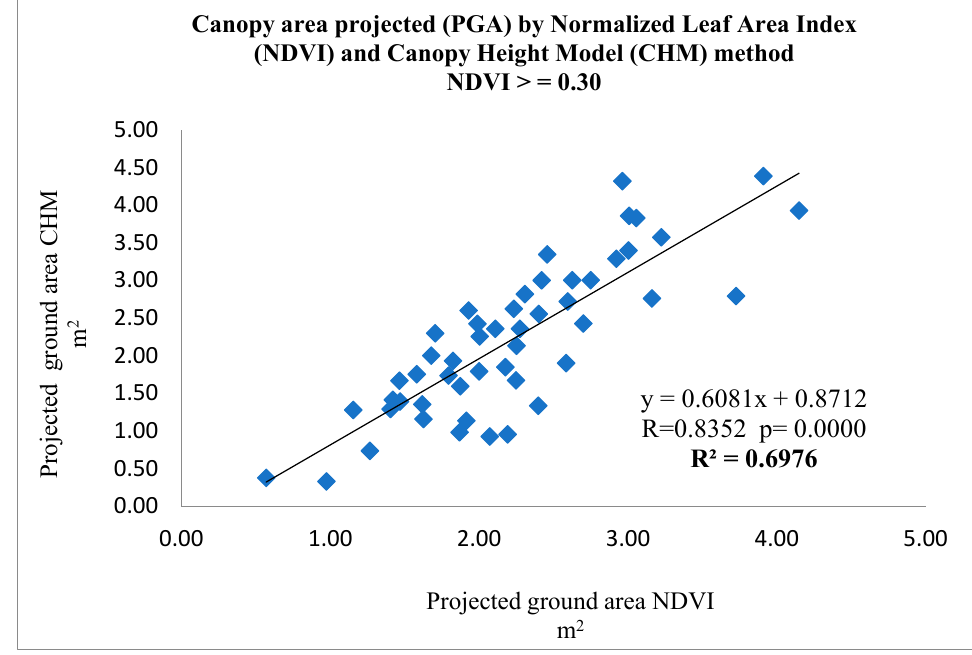
Figure 4. Relationship between PGA CHM vs. PGA NDVI with NDVI values > 0.30.